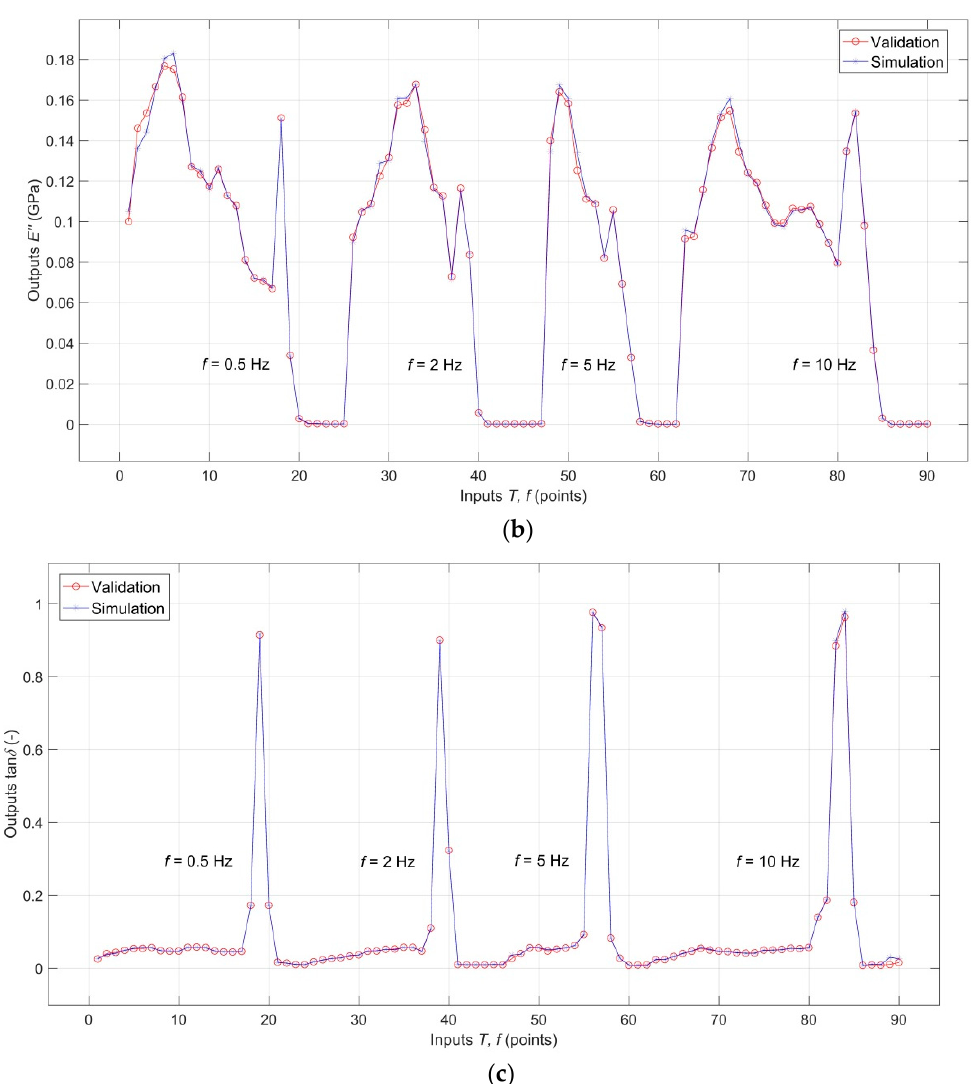
Figure 6. ( a ) Comparison of the validation targets with validation outputs for E ′ ( T, f ); ( b ) Comparison of the validation targets with validation outputs for E” ( T , f ); ( c ) Comparison of the validation targets with validation outputs for tan δ ( T , f ).